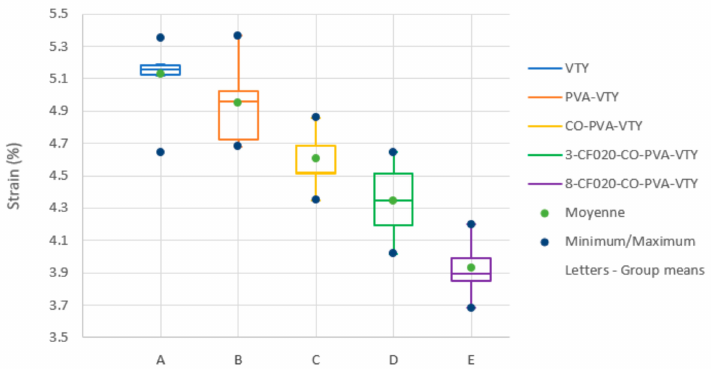
Figure 10. Box-plots of strain for each step allowing the realisation of sensor yarns. Letters A, B, C, D, and E on box-plots diagrams are the result of ANOVA analyses (Fisher’s test). NB: sample with different letters are scientifically